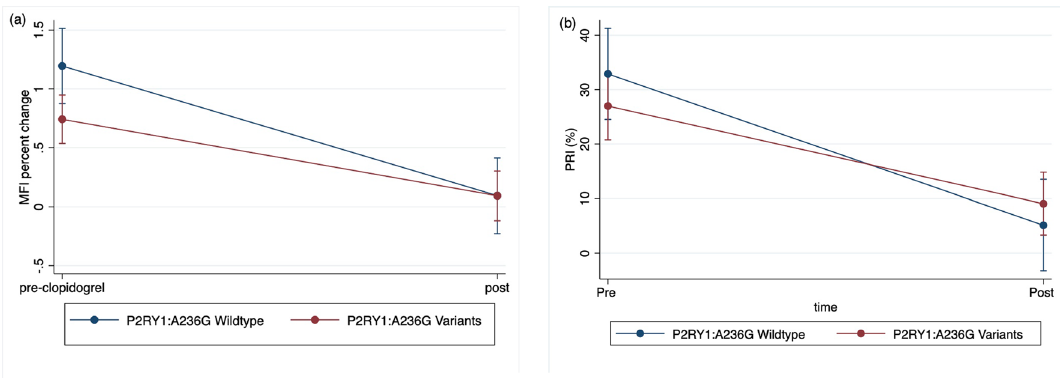
Figure 6. The means and 95% confidence intervals of ( a ) P-selectin mean fluorescence intensity (MFI) percent change and ( b ) platelet reactivity index (PRI) derived from phosphorylated vasodilator-stimulated phosphoprotein (P-VASP) expression before and after 10–14 day course of clopidogrel treatment are noted with a blue solid line for cats with P2RY1:A236G wildtype (c/c) and a red solid lie for the P2RY1:A236G variants (c/g and